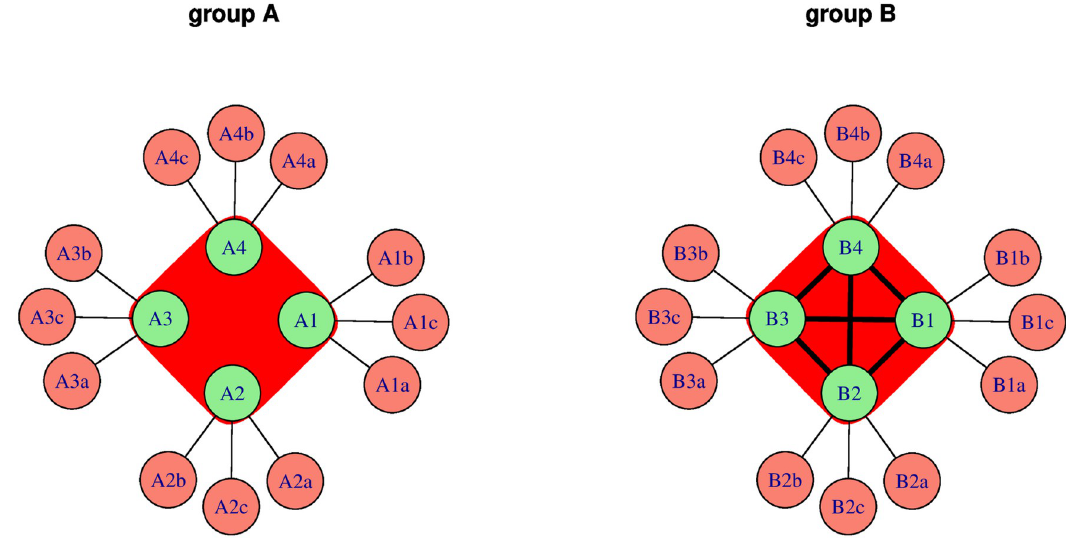
Fig 1. The publication relationships in groups A and B of the model. Nodes are authors, while edges symbolise shared publications. Groups of four authors are marked by the underlying shapes. In group A authors work with several coauthors from outside of the group but they do not invite group mates to be coauthors on their own papers. Contrarary, authors in group B form a publication cartel i.e. each author invites all other authors in the group to be a coauthor (note the connections between group